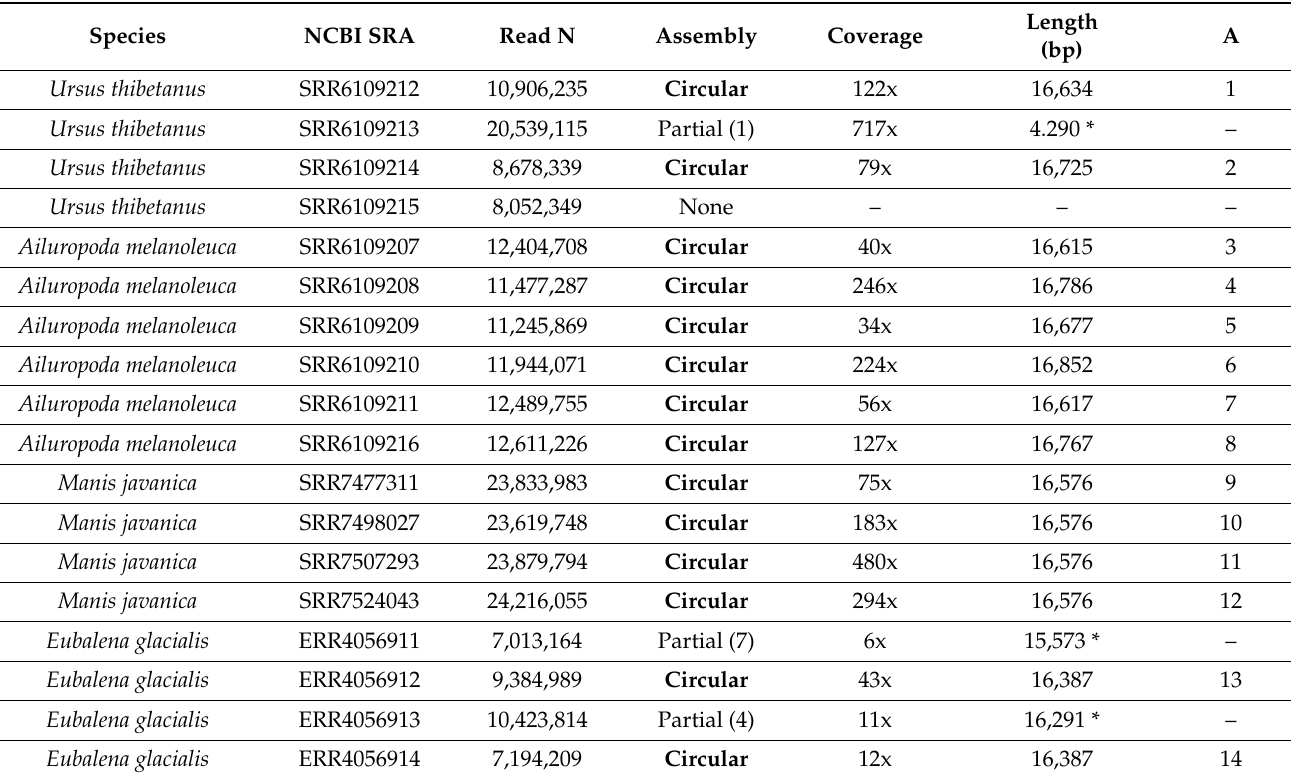
Table 1. Metagenomic datasets employed to assemble mitochondrial genomes. * = contigs total length in partially assembled mitochondrial genomes. A = assembly number in Supplementary